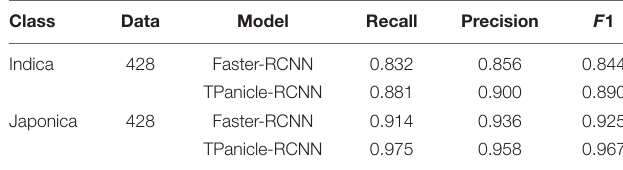
( Figure 7A ), resl01 ( Figure 7B ), and TPanicle-RCNN based